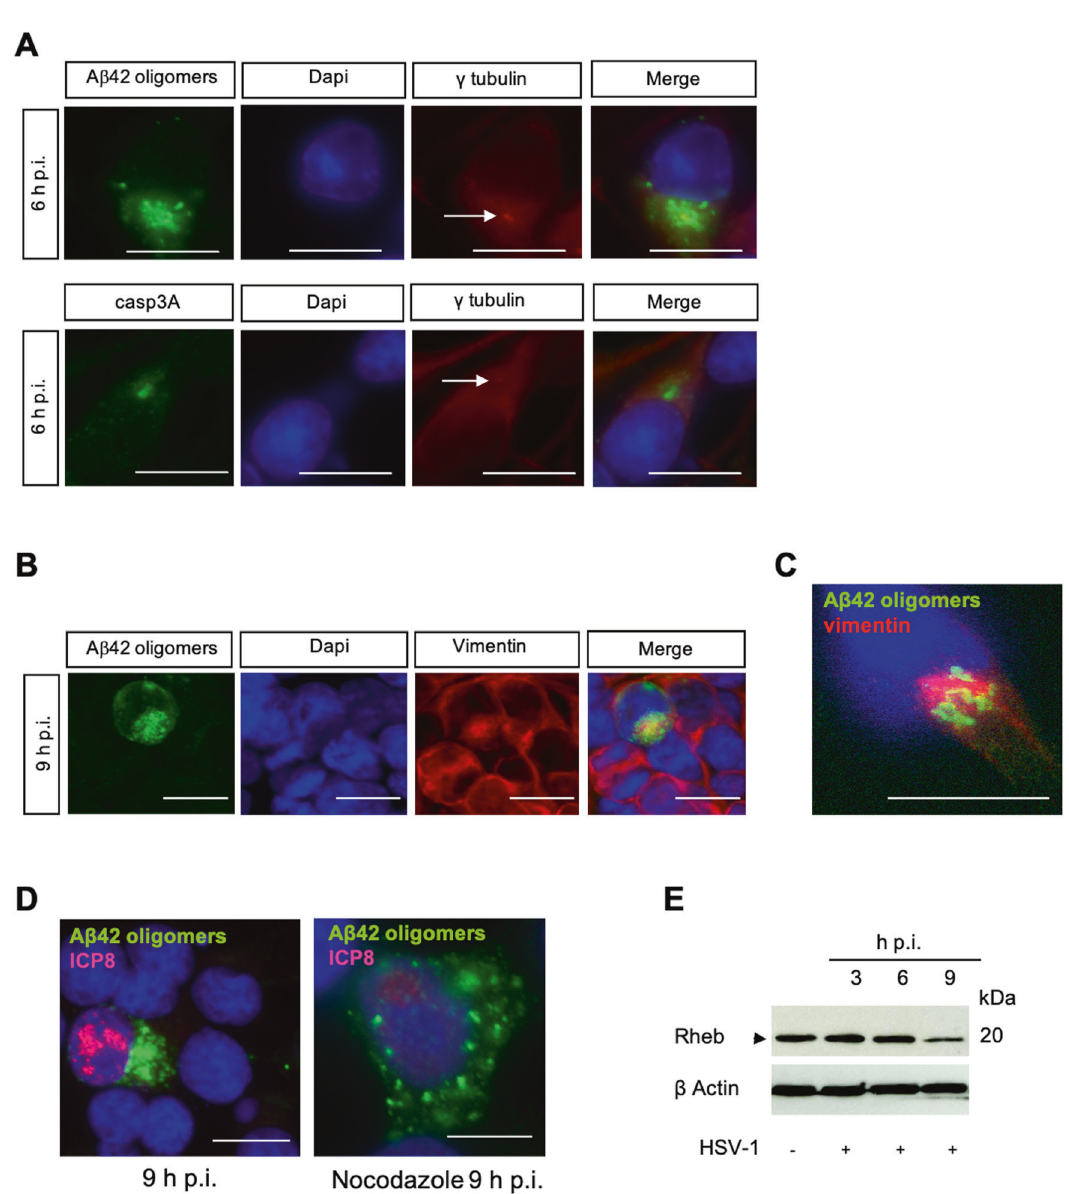
Fig. 4 HSV-1 induced accumulation of A β 42 oligomers and casp3A are aggresome. A IF analysis of A β 42 oligomers (A1976-Sigma) and casp3A (9664-Cell signaling) at 6 h p.i, γ tubulin is a MTOC control (white arrow) (magni fi cation X40), scale bar = 10 μ m. B IF analysis of A β 42 oligomers (A1976-Sigma) at 9 h p.i. Vimentin as control of aggresome formation (magni fi cation X40), scale bar = 10 μ m. C Confocal analysis of colocalization between A β 42 oligomers and vimentin, scale bar = 10 μ m. D IF analysis of A β 42 oligomers (A1976-Sigma) at 9 h p.i with or without nocodazole treatment. Viral protein ICP8 as control of infection (magni fi cation X100), scale bar = 10 μ m. E WB analysis of Rheb (4935- Cell signaling) at NI, 6 and 9 h p.i using anti-Rheb